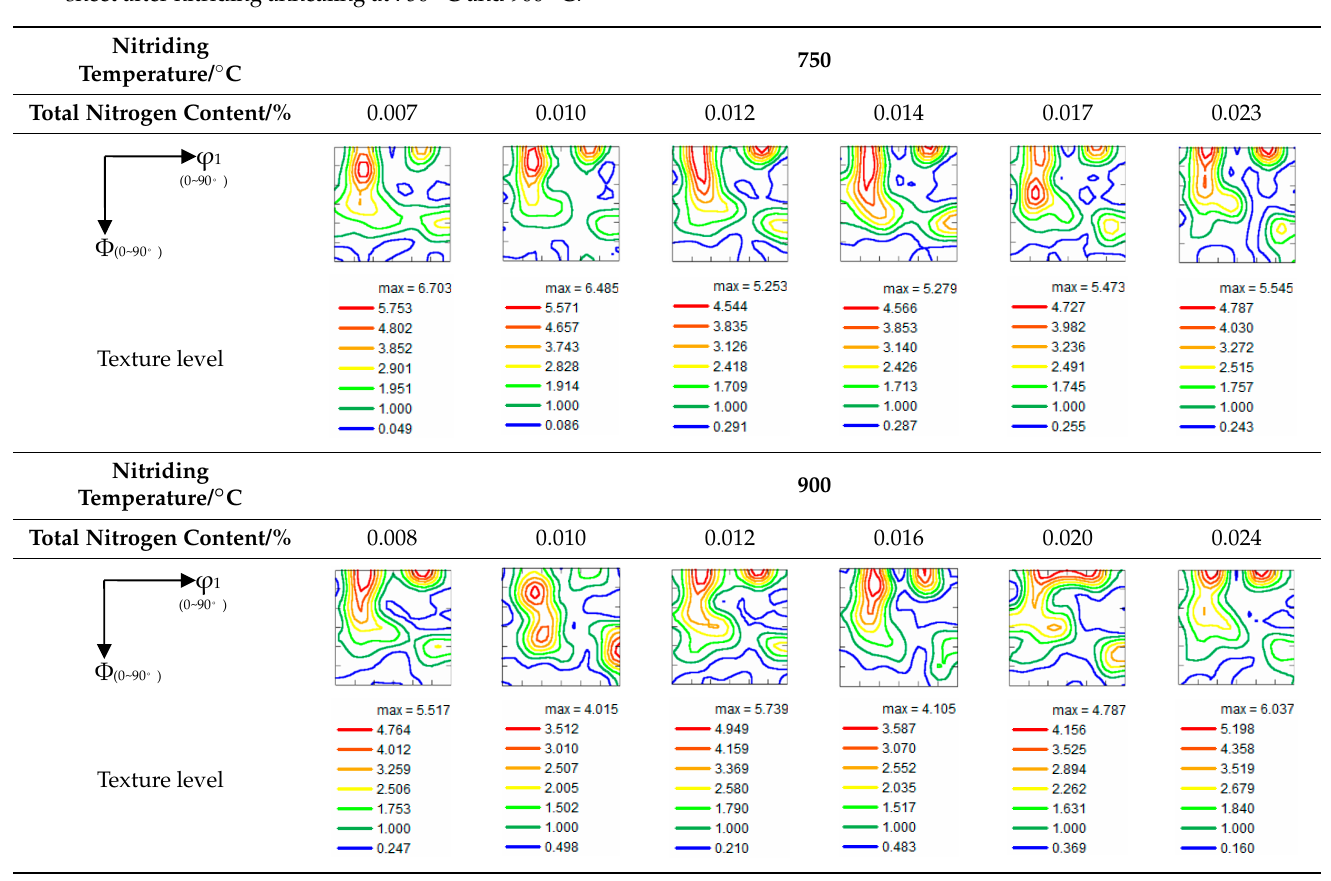
Table 2. Orientation distribution functions (ODFs) for a ϕ 2 = 45 ◦ section through the whole thickness of a decarburized sheet after nitriding annealing at 750 ◦ C and 900 ◦ C.